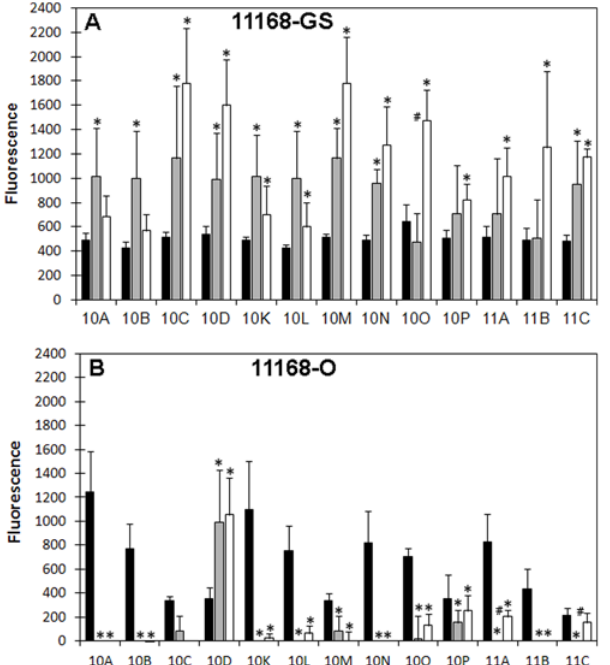
Figure 4. Binding of C. jejuni 11168 to Neu5Ac containing structures. Fluorescence intensities associated with C. jejuni 11168-GS (A) and C. jejuni 11168-O (B) binding to Neu5Ac containing glycans (25 u C, black bar; 37 u C, grey bar; and 42 u C, white bar). For the structure of the individual glycans refer to Table 2. * Significantly different to 25 u C, P , 0.05; # Significant difference between 37 u C and 42 u C, P ,